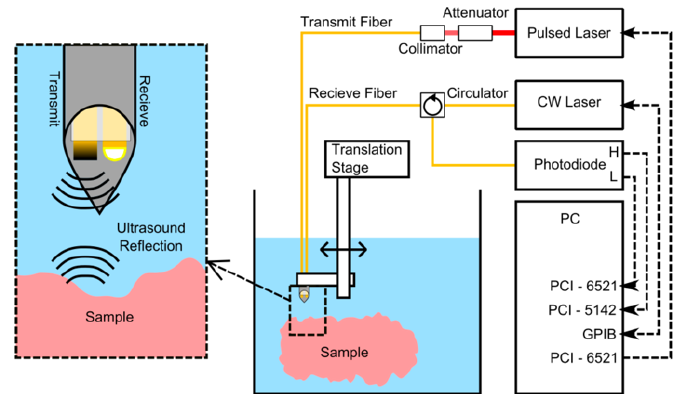
Figure 20. Schematic of the experimental setup for an all-optical ultrasound probe. Reproduced with permission from [60].